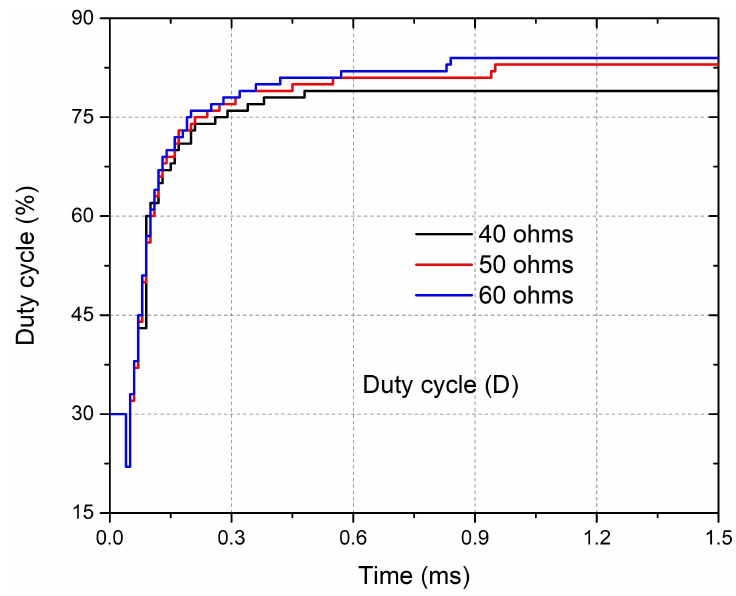
Figure 21. Duty cycle plot using the proposed algorithm.